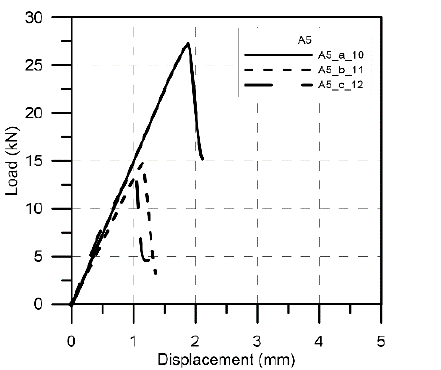
Table 6. Test results in terms of the mean capacity for each combination of crack width and anchor type.